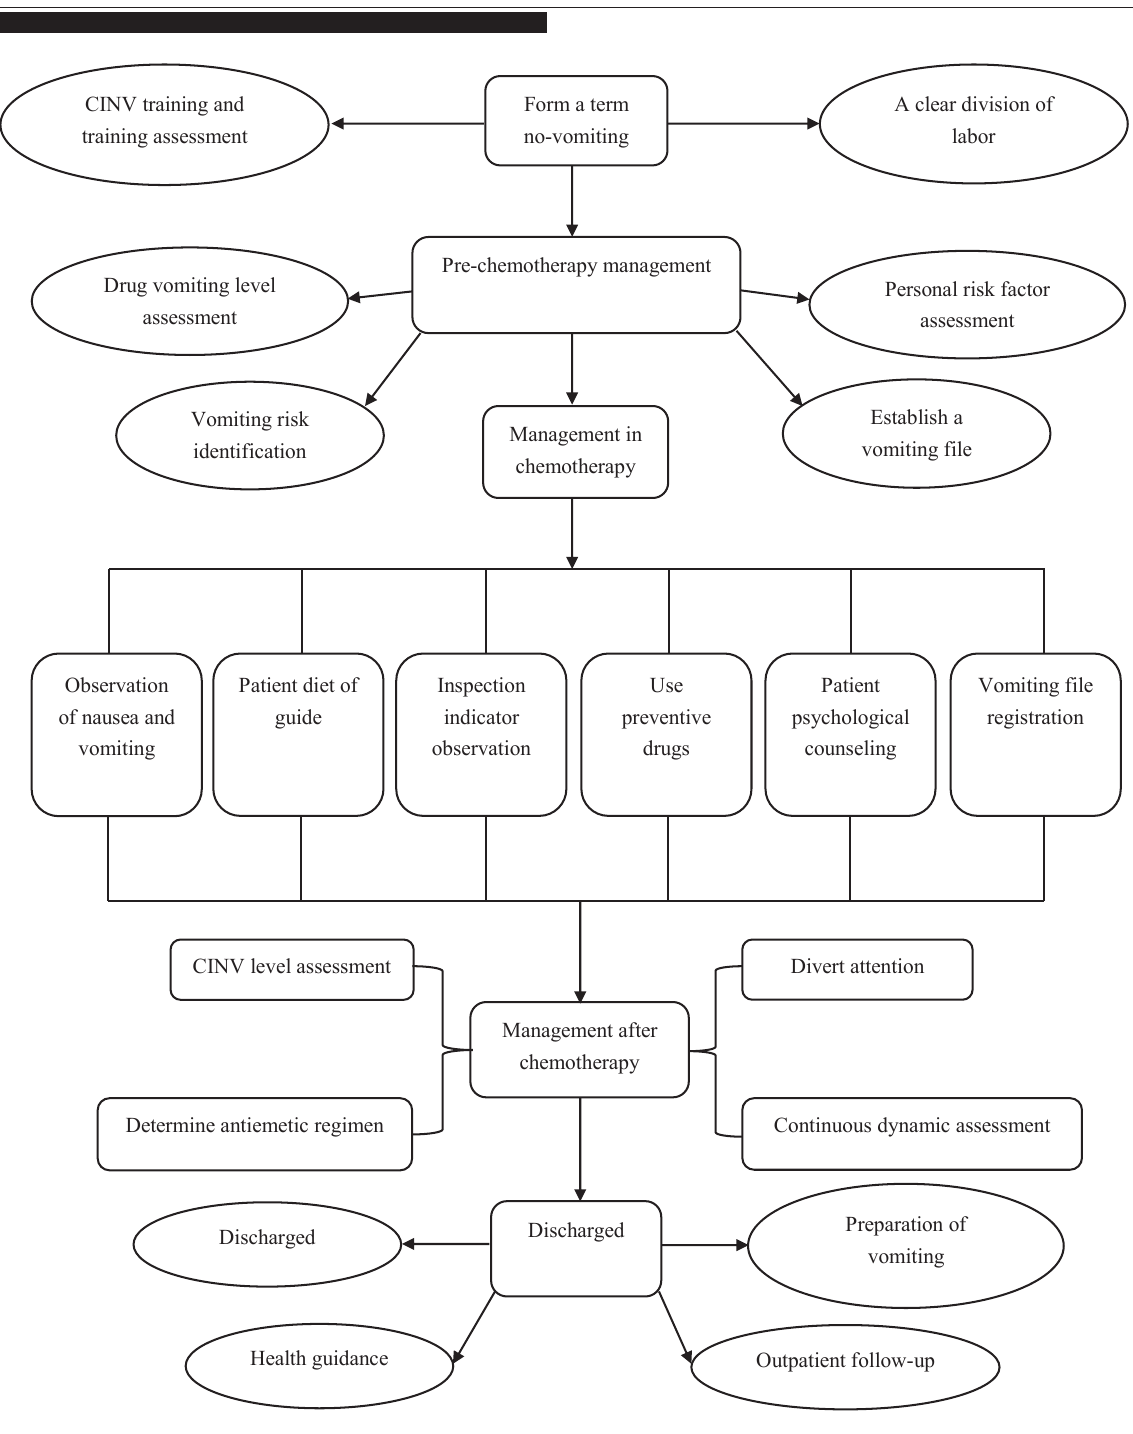
Figure 1. Standardized management of